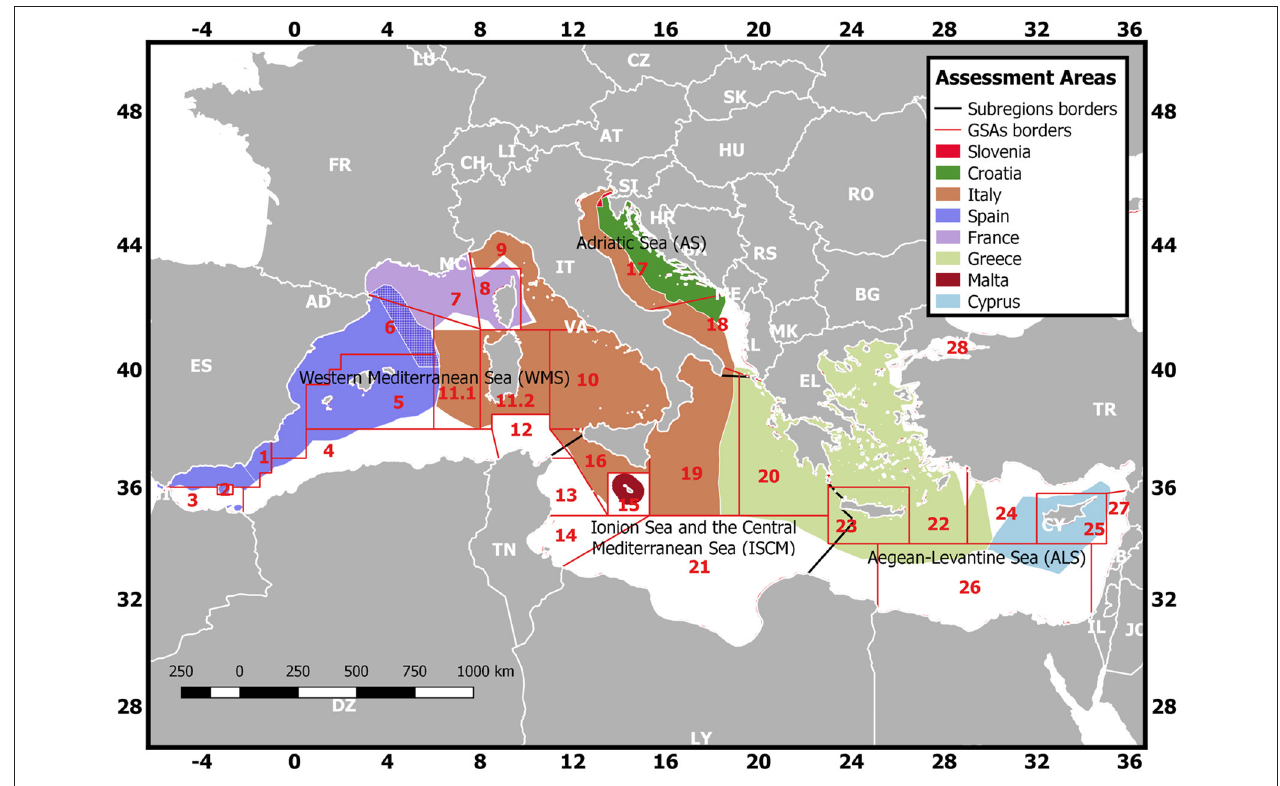
FIGURE 1 | The spatial boundaries of assessment areas identified by member states for the assessment of Descriptor 3 within the MSFD. Boundaries of FAO geographical sub-areas are also represented in the background. The area identified by the white crosses represents the overlap between France and Spanish assessment